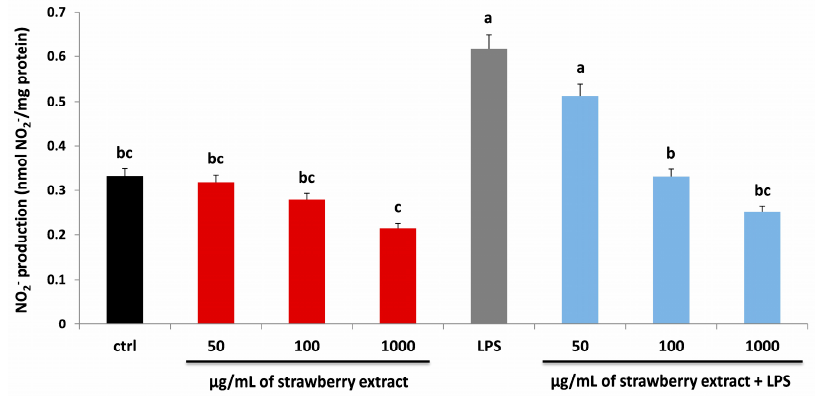
Figure 5. NO 2 − production in HDF cells treated with different concentrations of strawberry extracts (50, 100, 1000 µ g/mL) for 24 h (red bars), LPS (10 µ g/mL) for 24 h (grey bar) and with different concentrations of strawberry extracts and then with LPS (blue bars). Black bar represents the control group. Data are expressed as mean values ± SD. Columns with different superscript letters are significantly different ( p < 0.05).